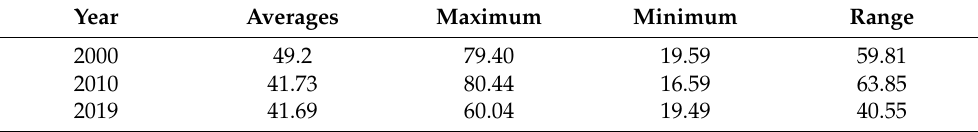
Table 2. Extremes and averages of accessibility of educational facilities in the YGGRD, 2000–2019. Year Averages Maximum Minimum